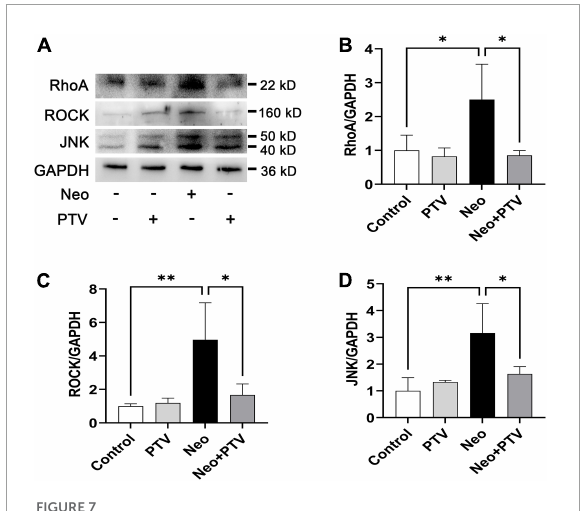
FIGURE7 PTV inhibits neomycin-triggered activation of the Rho/ROCK signaling pathway. (A) Western blot analysis of RhoA, ROCK, JNK, and GAPDH in HEI-OC1 cells with PTV pretreatment followed by neomycin exposure. (B–D) Quantification of the protein expression in (A) with ImageJ ( n = 3). ∗ p < 0.05, ∗∗ p <